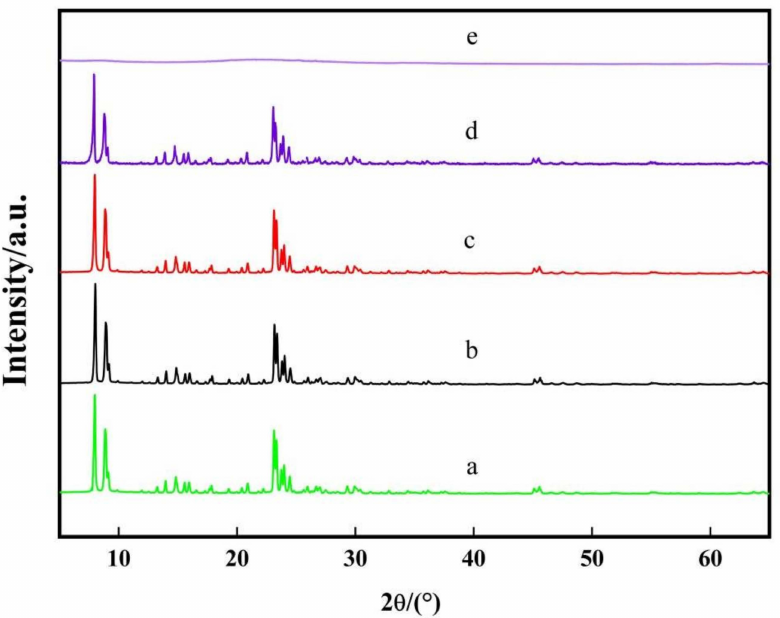
Figure 1. X-ray diffraction (XRD) patterns of pure ZSM-5 ( a ) and composite products with different